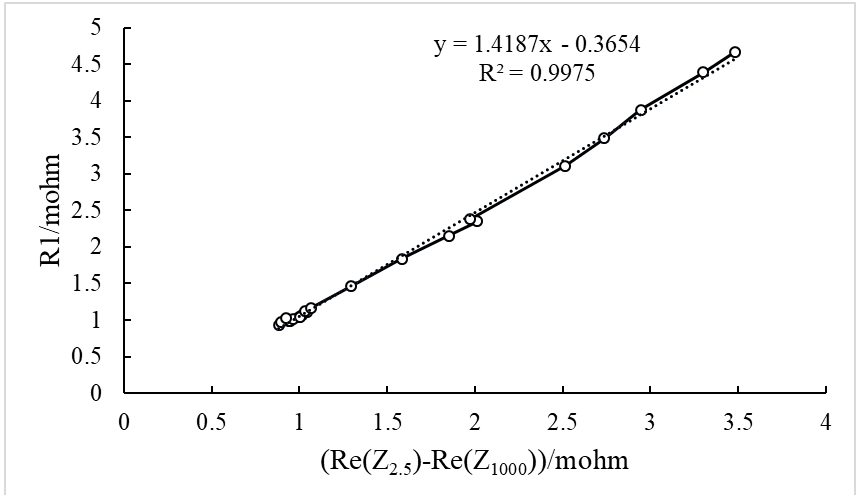
Figure 8. The correlation between Re( Z 2.5 )–Re( Z 1000 ) and R 1